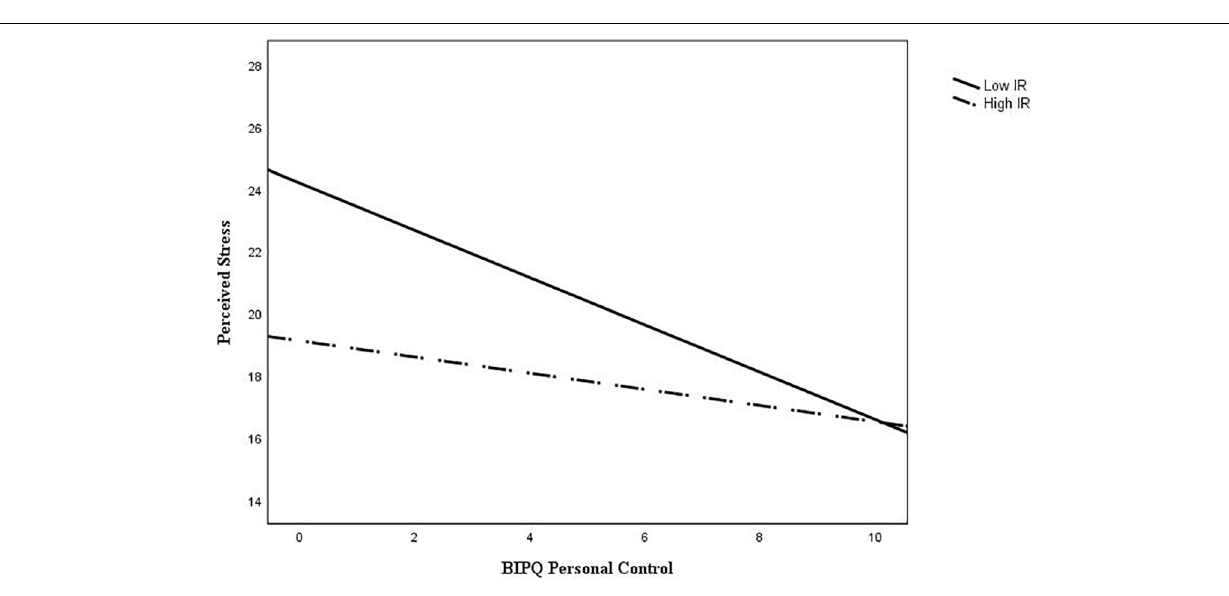
(1.25%), human attitudes (1.25%), and public emotional reaction (0.65%) were deemed as causes behind the